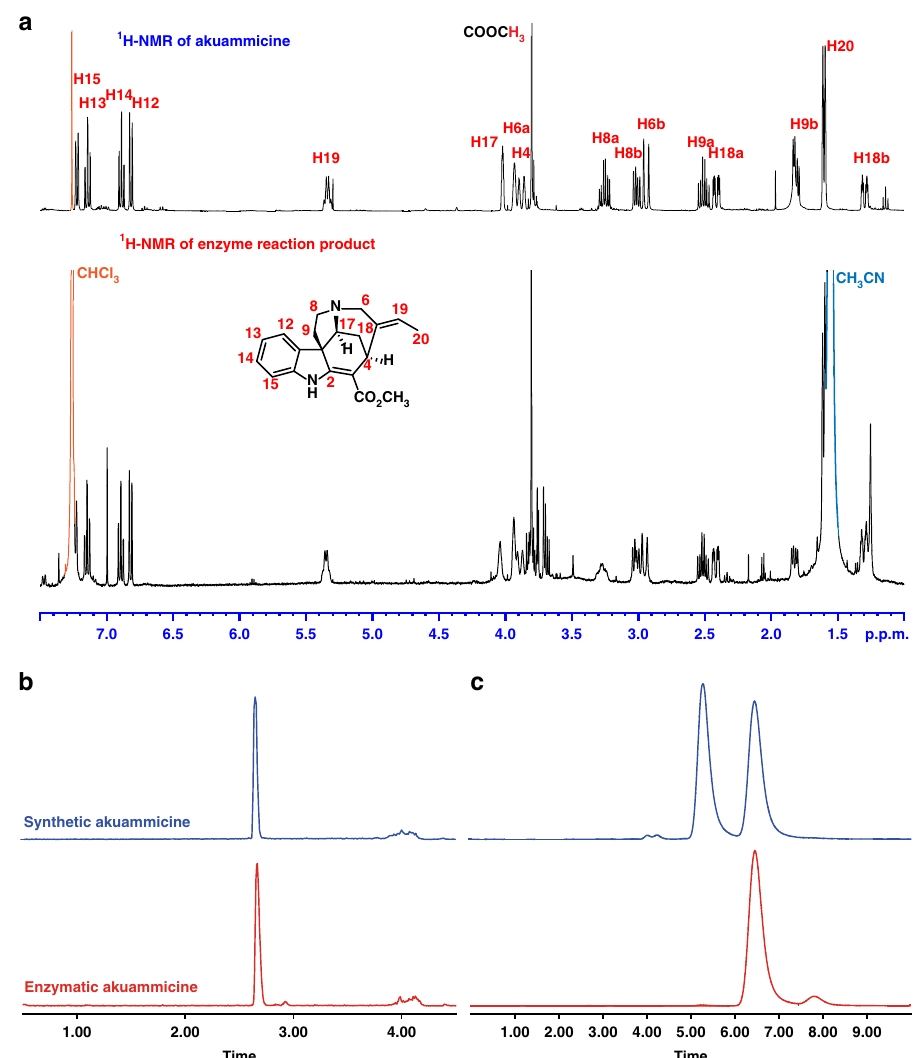
Fig. 3 Characterization of the GS1/GO product, akuammicine. a . 1 H NMR of enzymatically produced akuammicine compared to a synthetic standard (see also Supplementary Figs 19 – 23). b . LC-MS chromatograms with a standard reverse phase column comparing synthetic akuammicine with